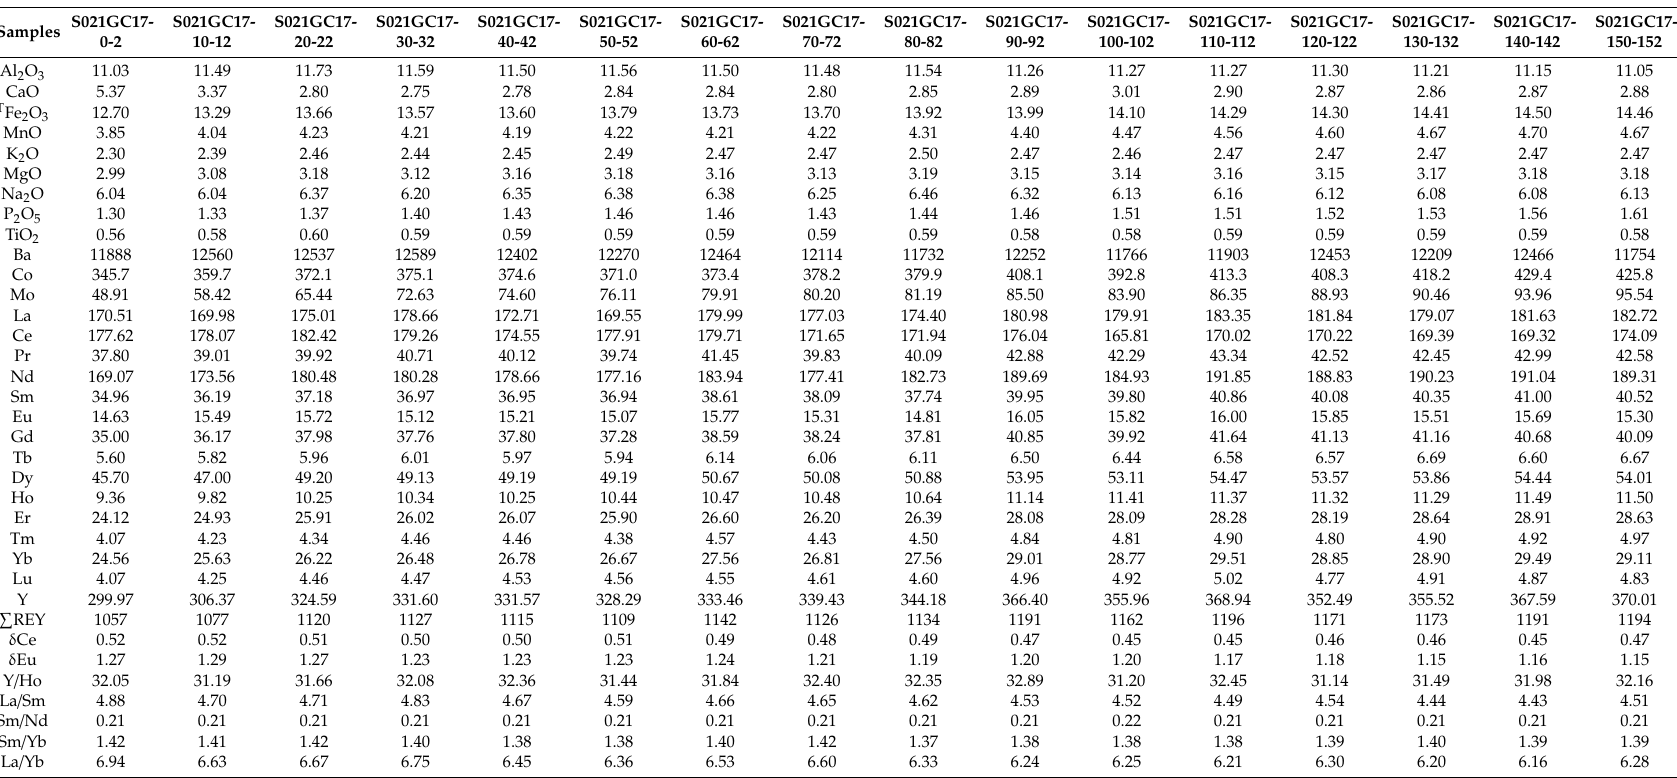
Table 1a. Bulk sediment geochemical data for the rare earth elements and yttrium (REY)-rich deep-sea sediments from the Yupanqui Basin. S021GC17- Samples